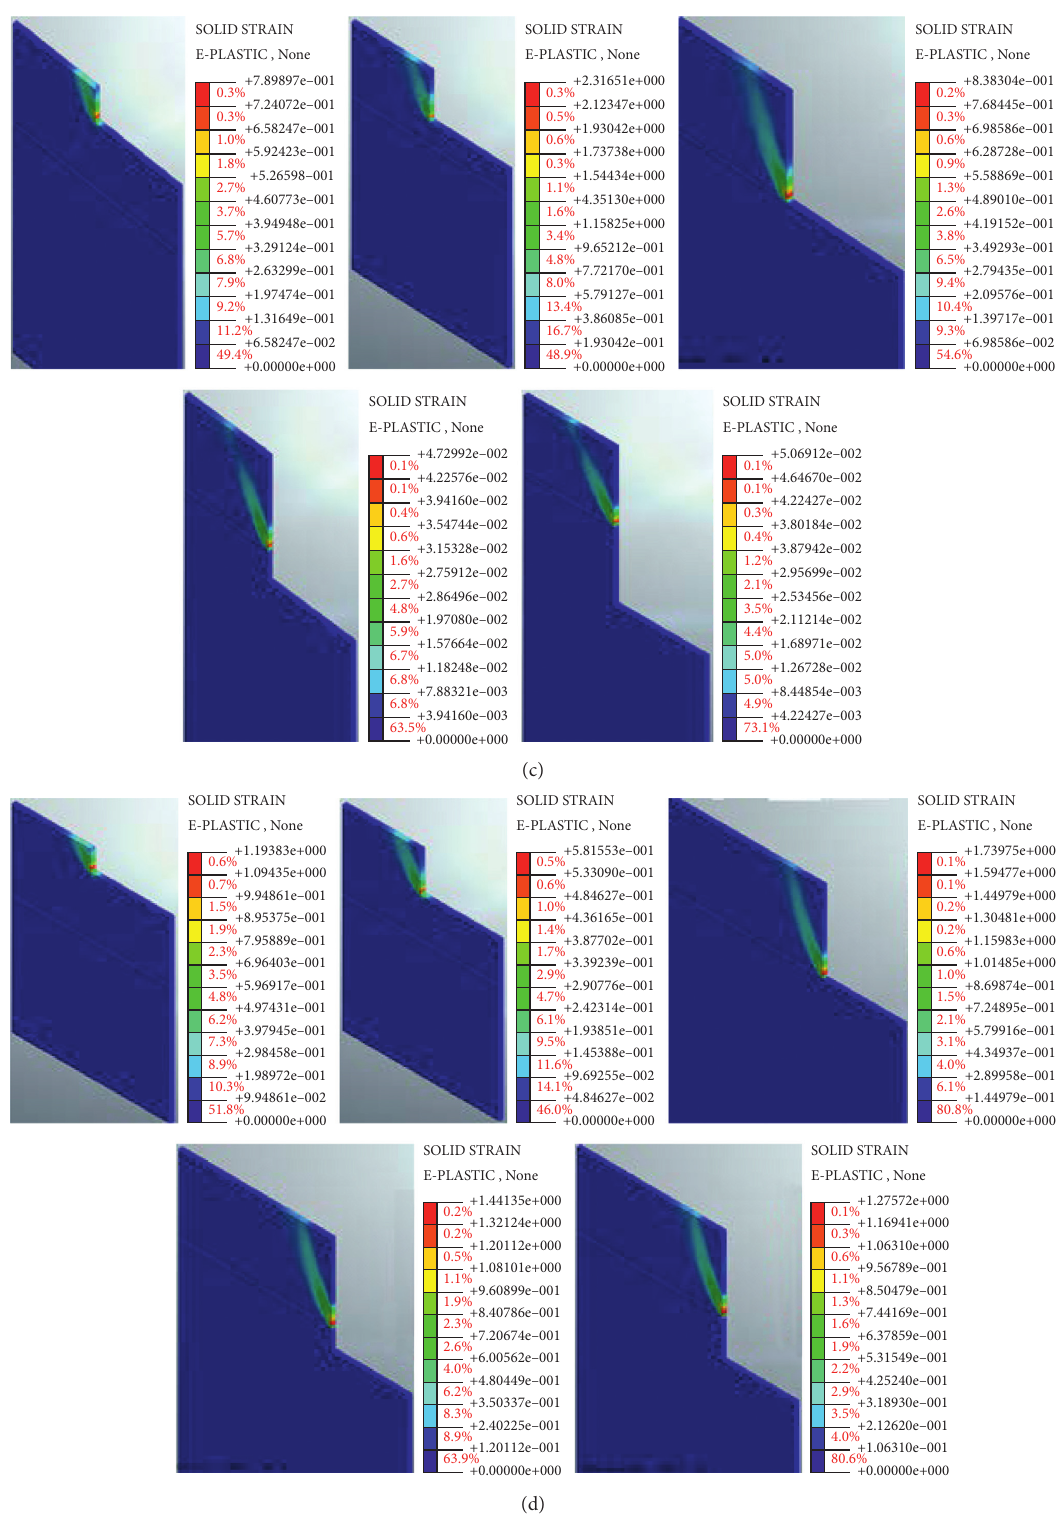
Figure 5: Potential fracture surface of deep foundation pit. (a) Hs � 5 m. (b) Hs � 10m. (c) Hs � 15m. (d) Hs �